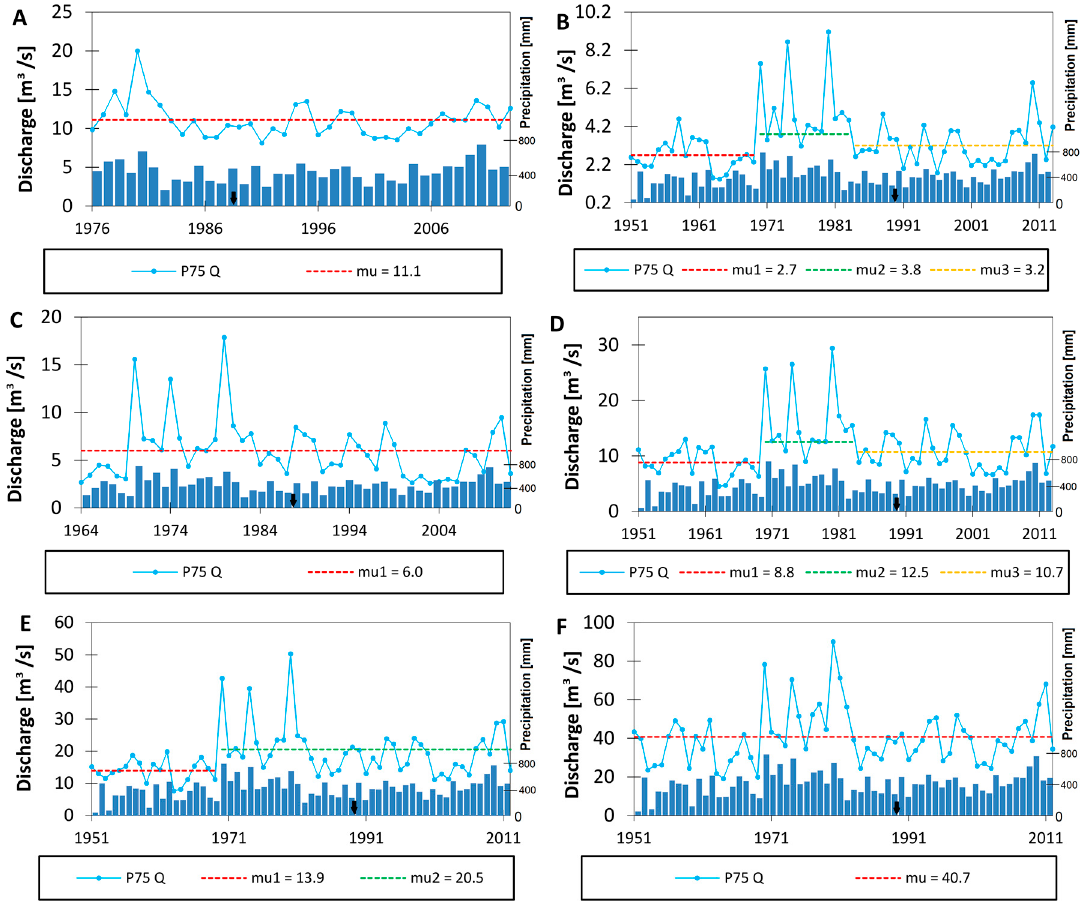
Figure 6. Annual third quartile discharge for selected gauge stations of the Upper Narew Catchment: ( A ) Fasty, ( B ) Narewka, ( C ) Bondary, ( D ) Narew, ( E ) Sura ż , and ( F ) Str ę kowa Góra. “mu” stands for the average value of each time period. The black arrow indicates the year the SR started operation.